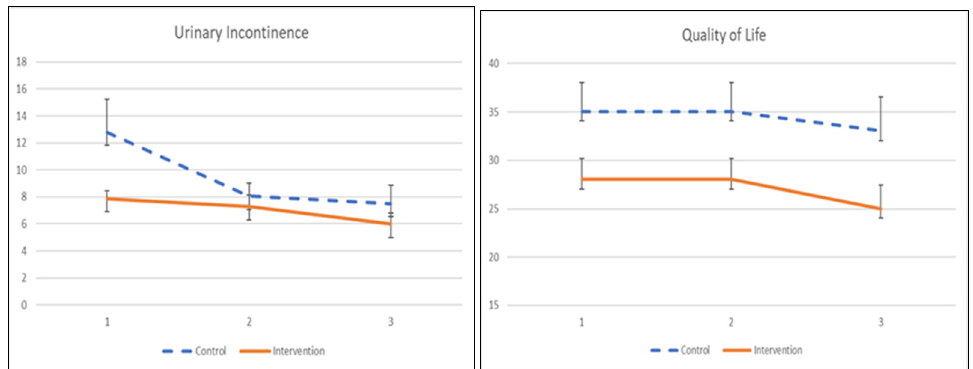
Figure 4. The mean values and standard errors for urinary incontinence severity and quality of life of the two groups across this pilot RCT study.